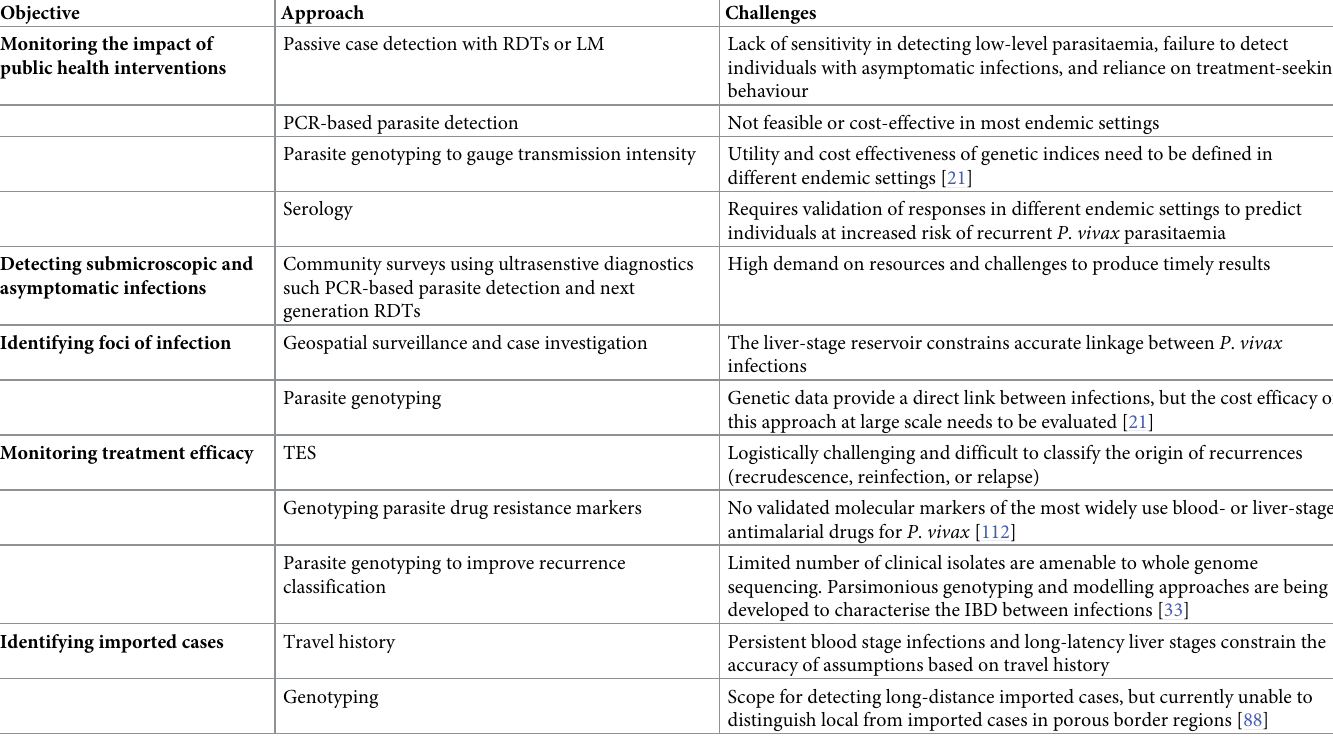
Table 3. Challenges with conventional and new surveillance